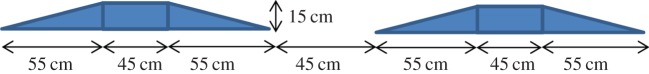
Dimensions of the ramp task as seen from the side. The ramps were 40 cm wide and made of black ridged plastic.